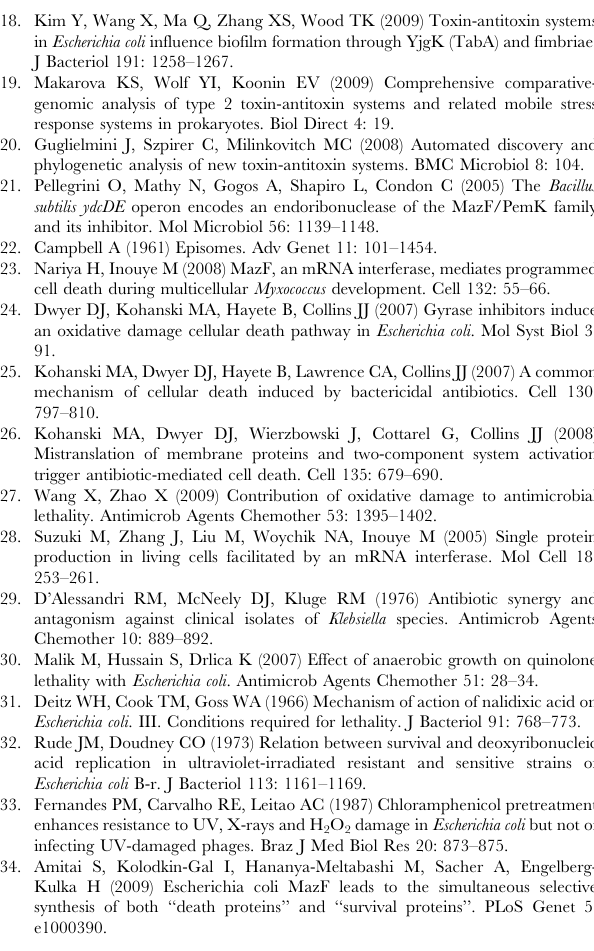
Figure S1 Effect of ndoA deficiency on bacterial growth. Wild-type strain (BD630, filled circles) and its D ndoA mutant (3169, open circles) were grown as single colonies on LB agar by overnight incubation at 37 u C. A single colony was inoculated into 5 ml of LB broth and incubated at 37 u C. Bacterial growth was monitored as turbidity increase at the indicated times. Error bars indicate standard deviation. (TIF) Figure S2 Effect of ndoA deficiency on bacterial survival after treatment with ciprofloxacin, oxolinic acid, and mitomycin C. Wild-type strain (BD630, filled circles) and its D ndoA mutant (3169, open circles) were treated with the indicated concentrations of ciprofloxacin for 120 min (panel A), oxolinic acid for 180 min (panel B), or mitomycin C for 30 min (panel C). Error bars indicate standard deviation; similar results were obtained in replicate experiments. (TIF)